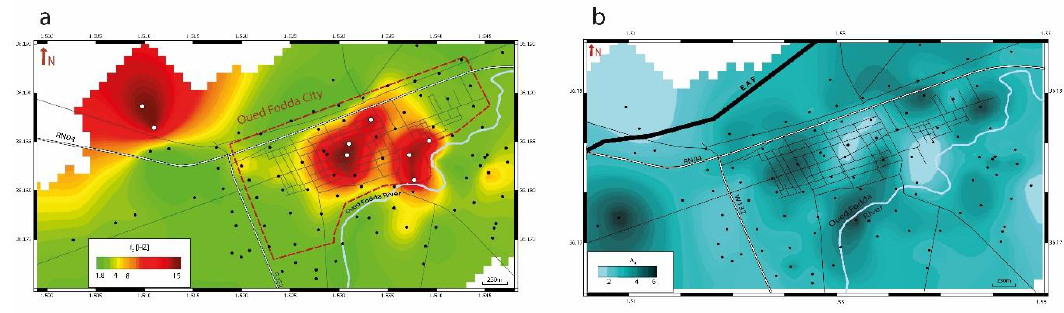
Figure 6. ( a ) Fundamental frequencies obtained from the HVSR analysis. Black dots represent the measurement points, while white dots represent the flat HVSR curves. ( b ) The corresponding amplification factors map.